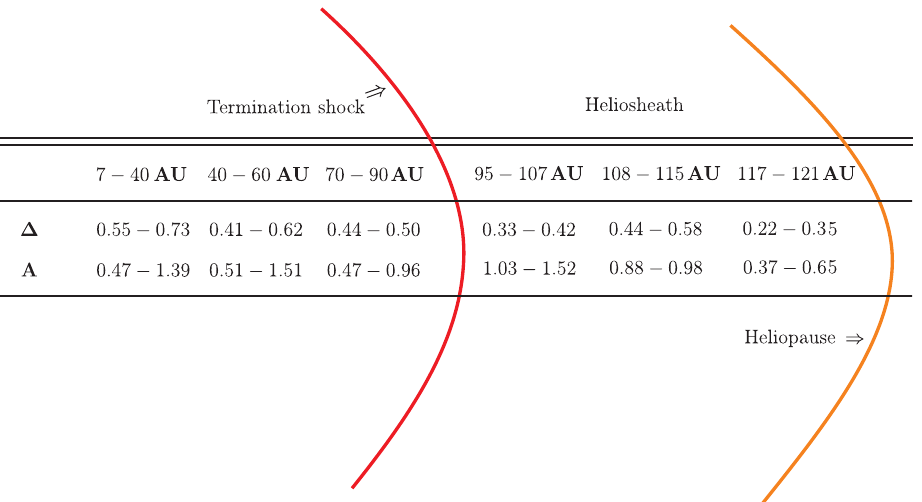
Figure 6. The degree of multifractality (cid:49) and asymmetry A in the heliosphere as a function of the distances from the Sun. The termination shock (TS) and the heliopause (HP) crossings by Voyager 1 are also indicated (cf. Macek, 2012).